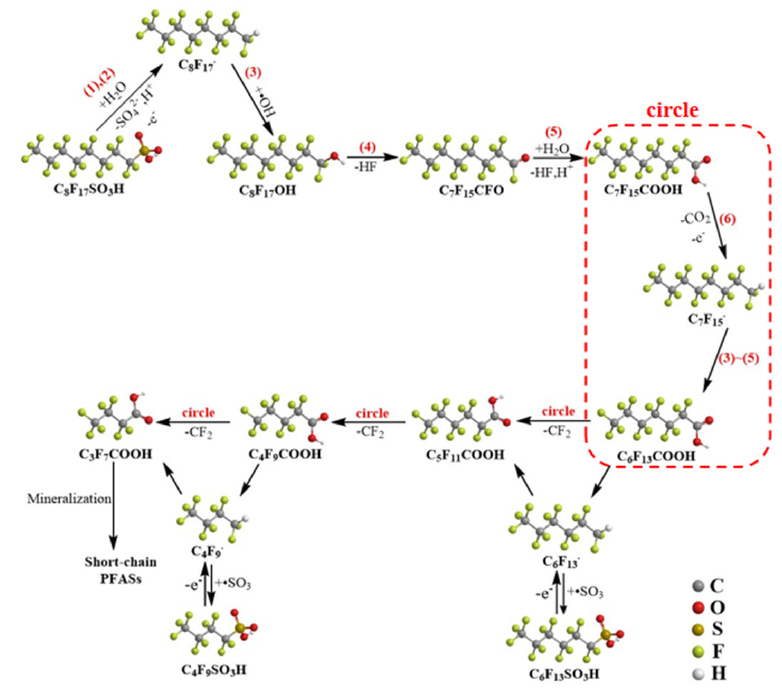
Figure 3. Proposed pathways for electrochemical oxidation of PFOS in water. Initially, the electrons are transferred from the terminal functional group of PFASs to the anode driven by the electric field and formed PFAS radicals ( · C n F 2n+1 COO or · C n F 2n+1 SO 3 ), the extremely unstable PFAS radicals undergo decarboxylation or desulfation to form · C n F 2n+1 . The generated · C n F 2n+1 could react with H 2 O, OH − , or · OH, and finally -CF 2 groups were cut down gradually to generate short-chain PFASs with the specific reaction equations shown in (3)–(7)